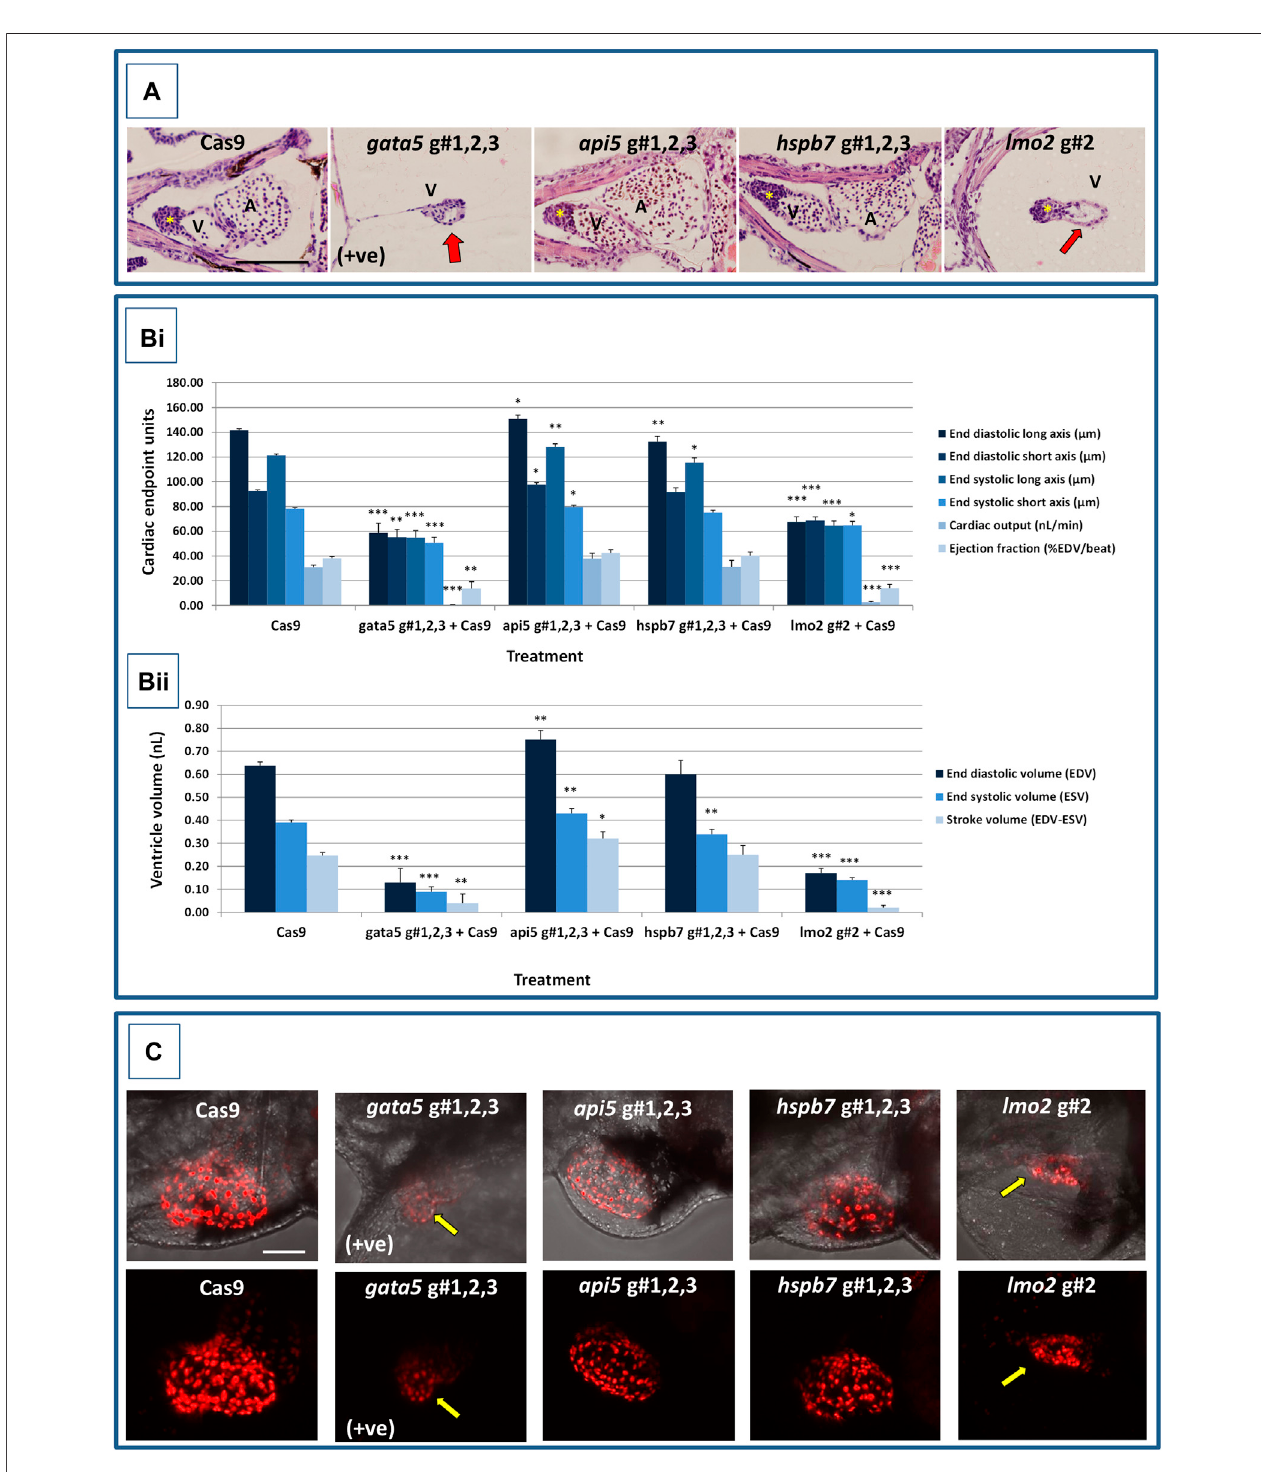
FIGURE 4 | Results of the cardiac pathological analysis of 4 dpf gata5 (positive control), api5 , hspb7 and lmo2 zebra fi sh crispants vs. the Cas9-injected control animals. Panel (A) Example haematoxylin and eosin stained coronal sections through the heart (top, A = atrium, V = ventricle, *bulbous arteriosus) from each of the treatment groups vs. the Cas9-injected controls (left-hand panels). Note in particular the extreme cardiac hypoplasia after gata5 and lmo2 mutation (indicated by a red arrow in the images) in which the atrium is not visible probably due to the severe pericardial oedema and resultant distension of the heart muscle. In each panel, animalsareorientatedwiththeheadtotheleft,andviewedinthedorsalplaneatamagni fi cationof×40(thescalebarshowninleft-handimagerepresents200 μ m).Panel B) Results of the analysis of ventricular dimensional analysis of the crispant vs. Cas9 control animals. Shown are the ventricle dimensions and cardiac functional